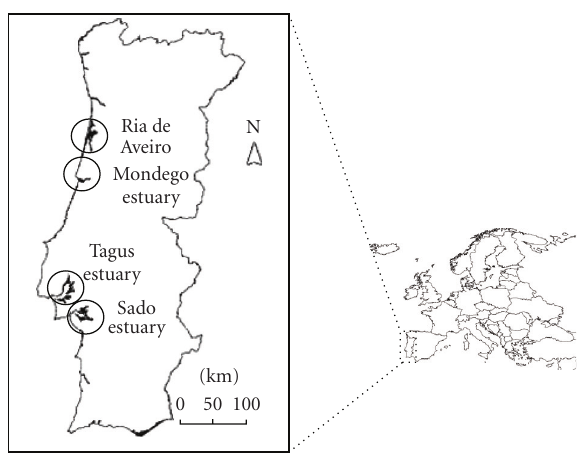
Figure 1: Maps of Europe and Portugal and the localization of coastal wetlands in the study; the coastal lagoon of Aveiro (Ria de Aveiro), and the estuaries of Mondego, Sado, and Tejo (Tagus